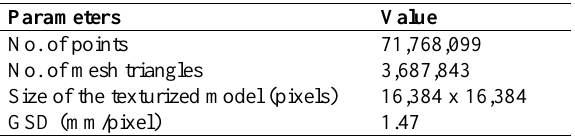
Table 2. Summary of the products derived from the photogrammetric model.